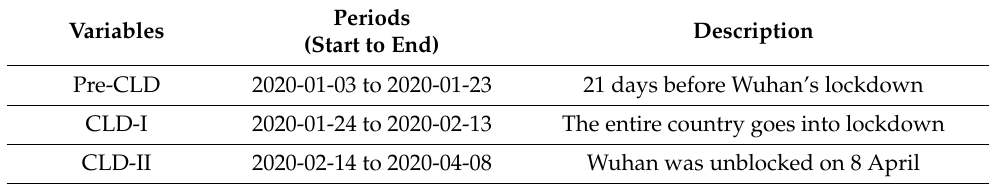
Table 1. The study period for